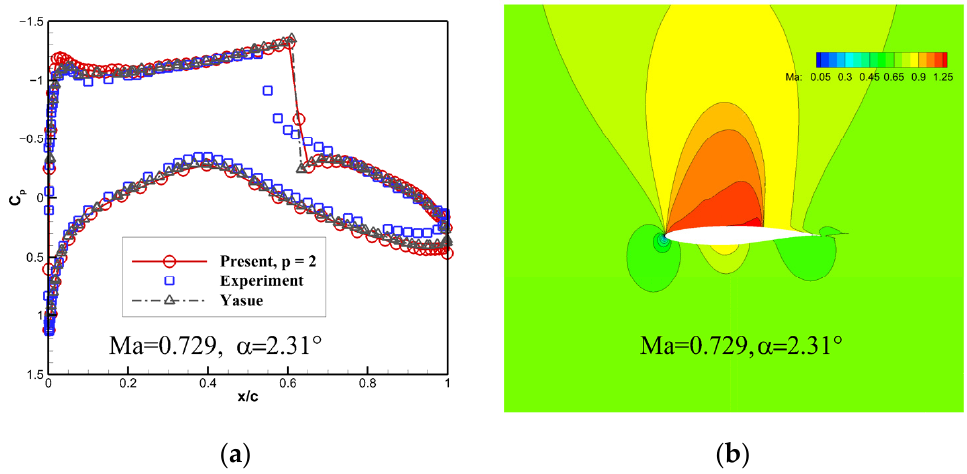
Figure 9. Computational results for the transonic flow around a RAE2822 airfoil. ( a ) Surface pressure coefficients (Experiment [37], Yasue [38]); ( b ) Contours of Mach number.